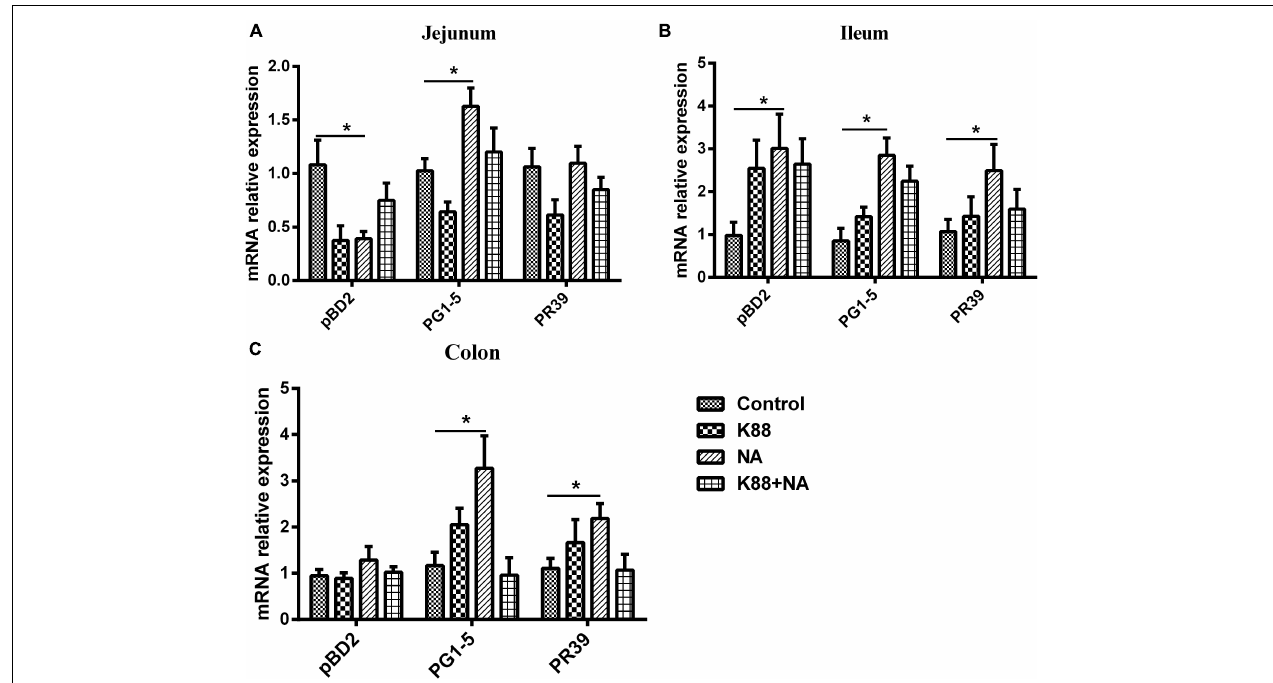
FIGURE 7 | Nicotinic acid improved the expression of intestinal antibacterial peptides caused by E. coli infection of weaned piglets. Real-time quantitative PCR was performed to determine the relative mRNA expression levels of pBD2, PR39, and PG1-5 in the jejunum (A) , ileum (B) , and colon (C) of weaned piglets were detected by real-time PCR. All data are expressed as the mean ± SEM, * P < 0.05.